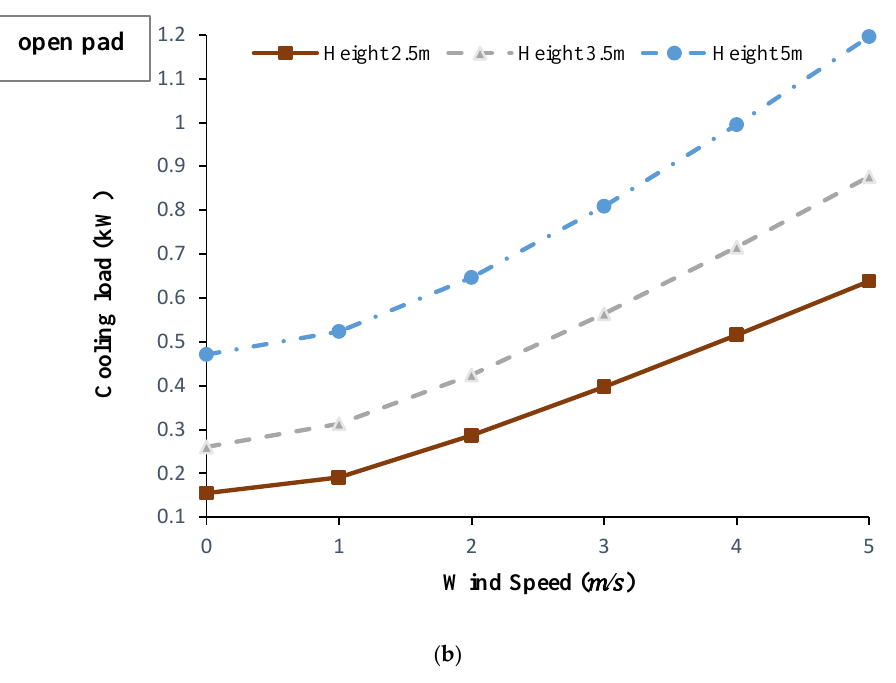
Figure 7. Effect of wind speed and wind catcher height on provided cooling load under the conditions of Qaen city at 12:00 p.m. on 3 May 2017 and the modes of: ( a ) closed pad, ( b ) open pad.